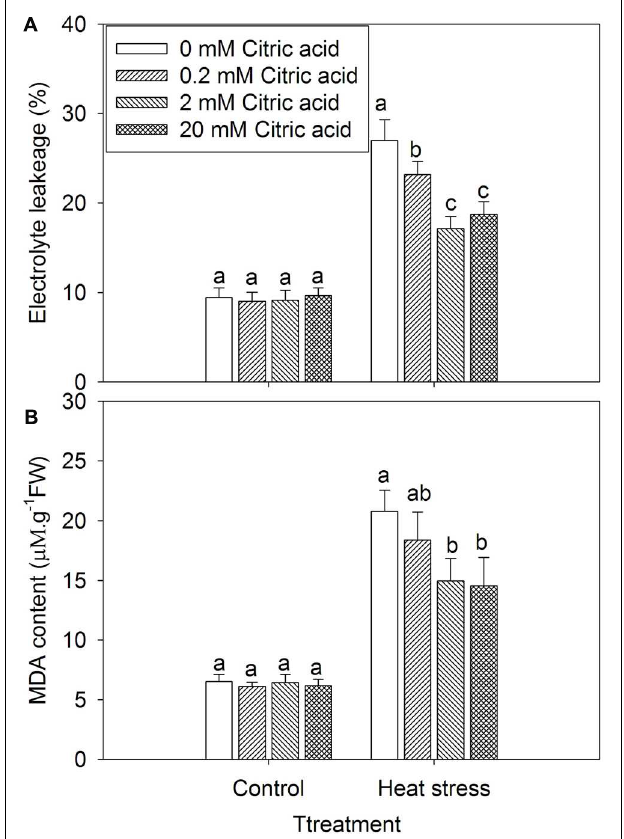
FIGURE 3 | Effect of exogenous citric acid on EL (A) and MDA content (B) under control (25/20 ± 0.5 ◦ C, day/night) and heat stressed (35/30 ± 0.5 ◦ C, day/night) conditions in tall fescue. Vertical bars on the top provide the standard deviation ( n = 4), and bars with the same letter indicate no significant difference at P < 0.05 for the comparison of different citric acid concentrations under control or heat stress.